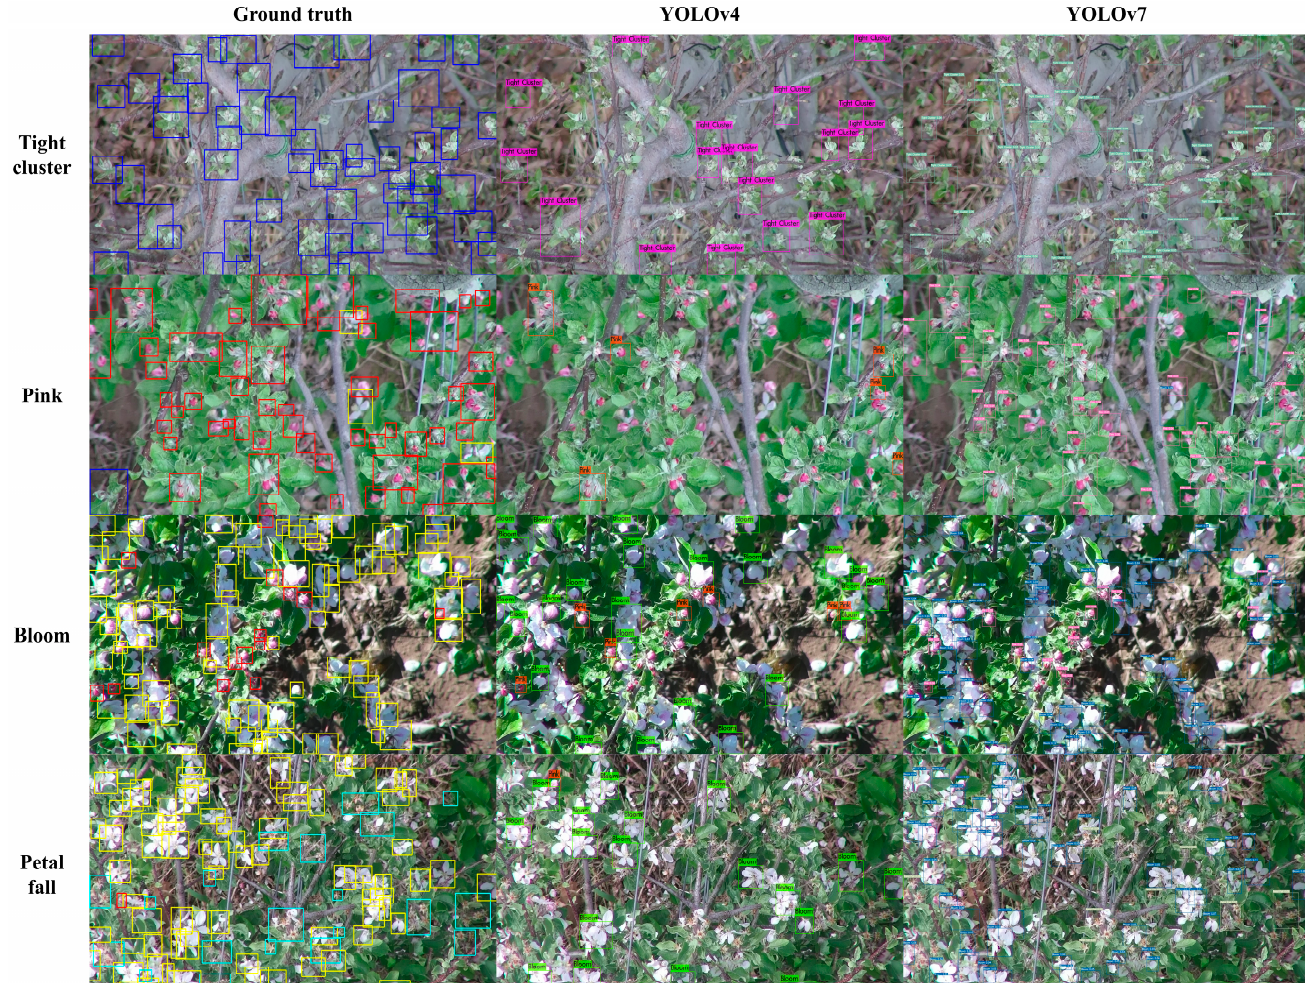
Figure 3. Apple flower bud detection results on sample test images based on a 3% confidence threshold using YOLOv4 and YOLOv7 models trained with 5% image annotation quality.